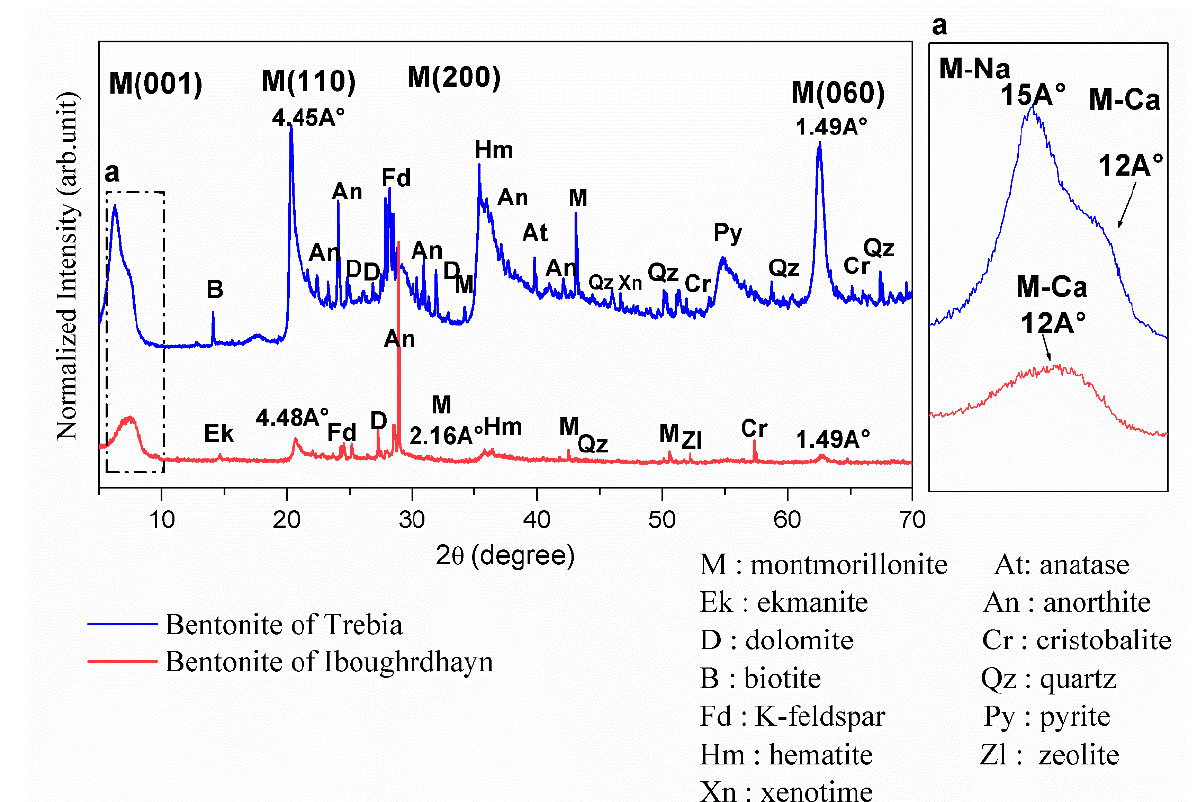
Figure 1. X-ray diffractograms of the raw bentonite samples.